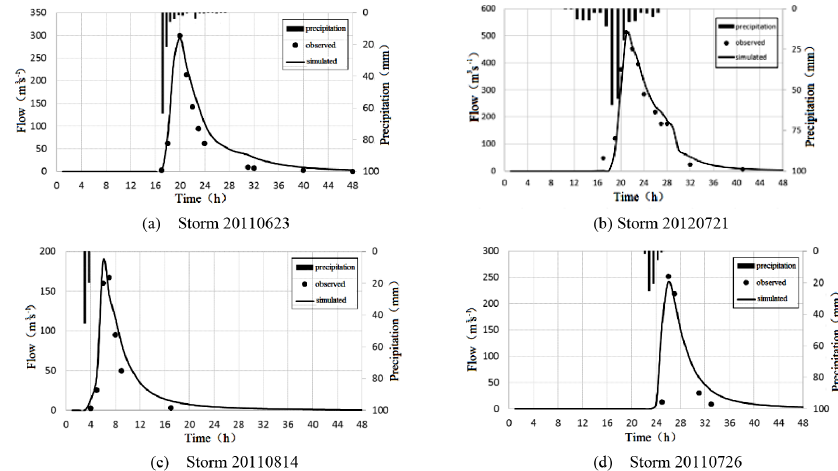
Figure 5. Simulation of flood after